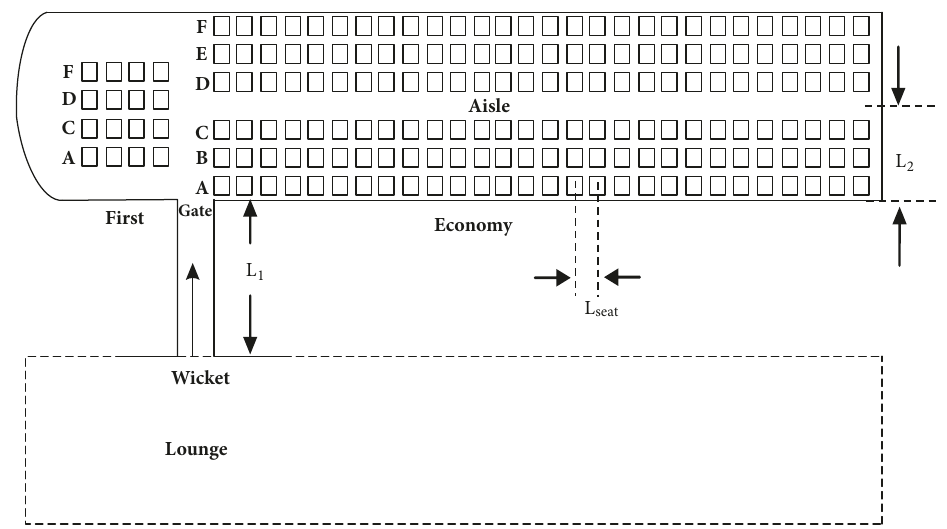
Figure 1: The scheme of an aircraft during the boarding